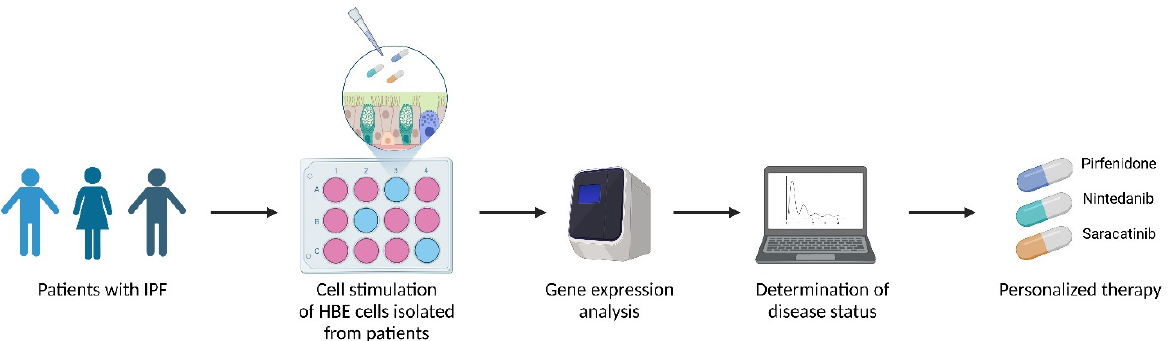
Figure 7. Gene expression analysis based on in vitro treatment of patient-derived bronchial epithelial cells with potential fibrotic drugs may determine disease status, and thus predict possible response towards drugs, before treatment. Created using BioRender.com.